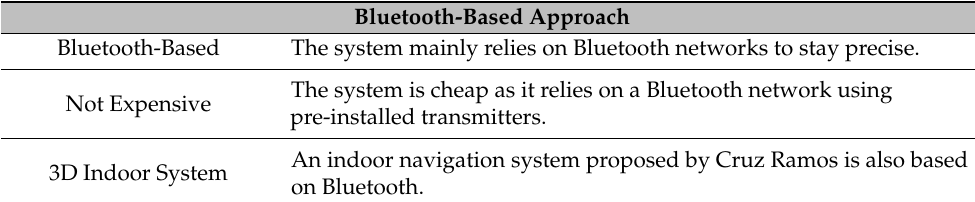
Table 11. Properties of Bluetooth-Based Navigation Tools. Bluetooth-Based Approach Bluetooth-Based The system mainly relies on Bluetooth networks to stay